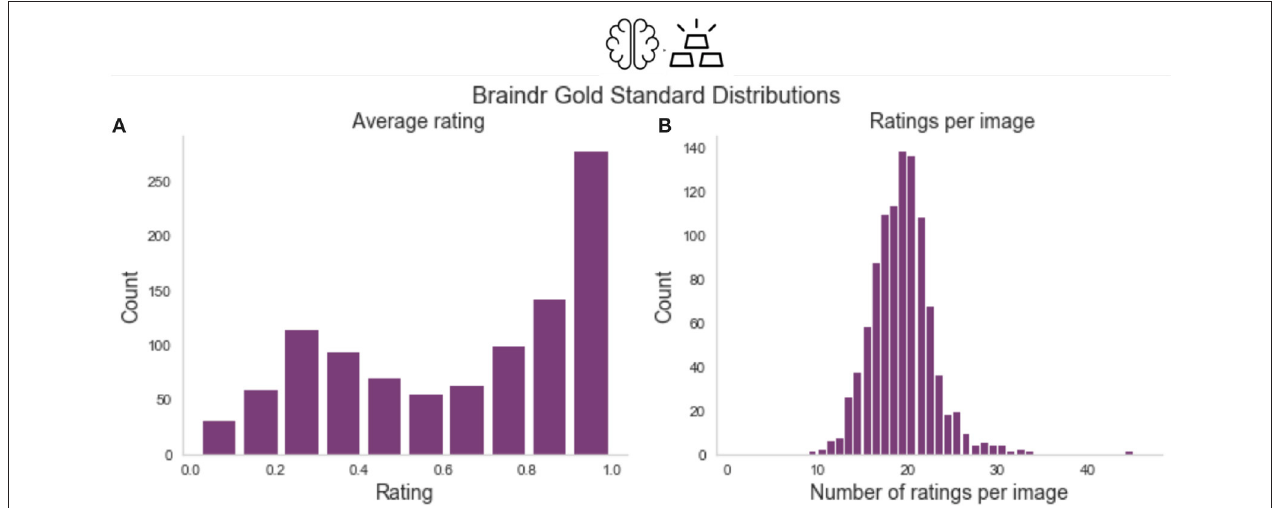
FIGURE 7 | Braindr data distributions. (A) Shows the distribution of average ratings for each slice on the gold-standard slices. (B) Shows the number of ratings per slice, where on average each slice received 18.9